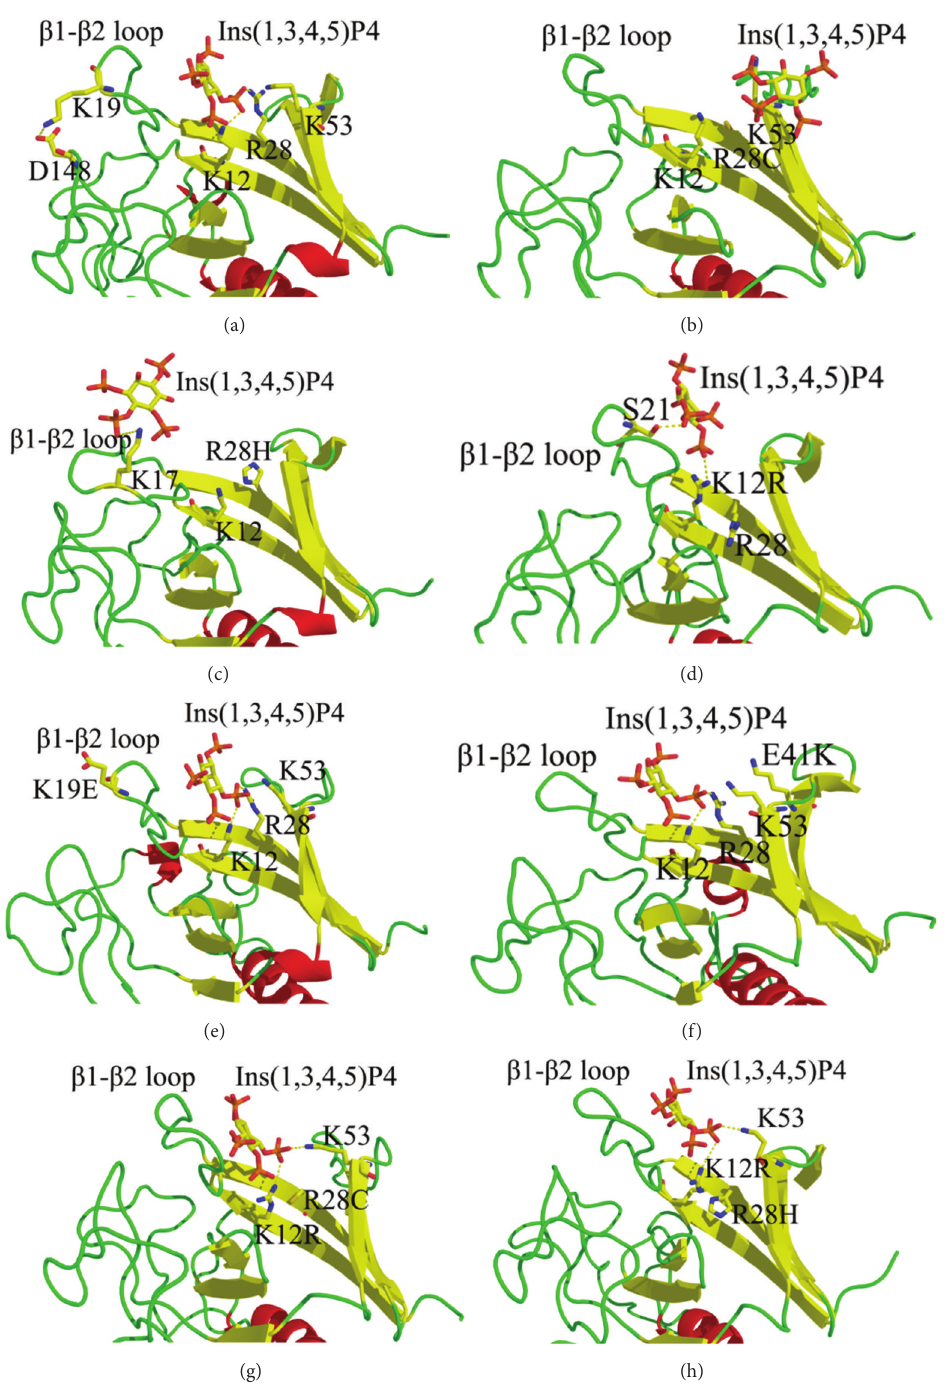
Figure 3: The snapshot structures taken at time 20 ns of wild type and all “functional mutations” complexes from MD simulation. Ligands and surrounding important residues are labeled and shown in stick, while hydrogen bonds are displayed in yellow dashed lines. (a) Wild type complex; (b) R28C mutation complex; (c) R28H mutation complex; (d) K12R mutation complex; (e) K19E mutation complex; (f) E41K mutation complex; (g) K12R-R28C mutation complex; (h) K12R-R28H mutation